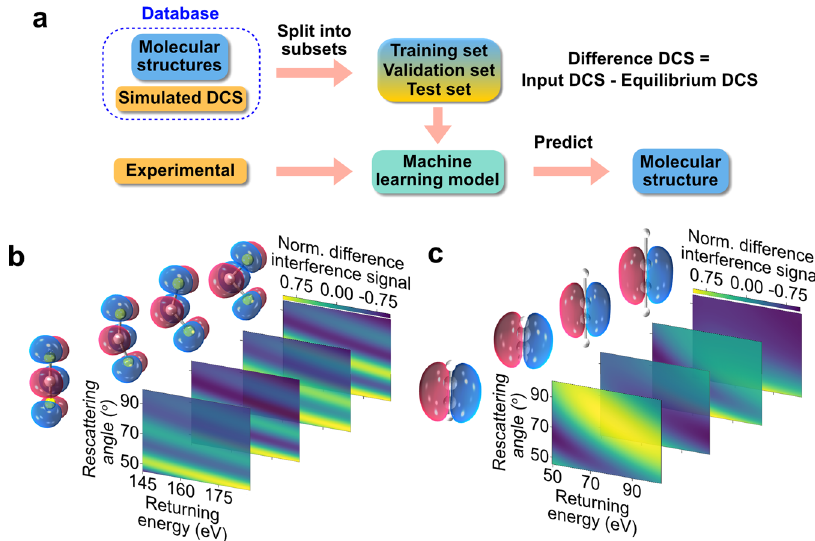
Fig. 1 Machine learning schematic. a A database of molecular structures and their corresponding simulated 2D-DCSs are split into three sets: training, validation, and test sets. Here, the simulated 2D-DCS maps are calculated via the independent atomic model (IAM). Once the machine learning (ML) model is validated, the experimental 2D-DCS map is used as an input to predict the molecular structure that most likely contributes to the measured interference signal. b , c Exemplary simulated difference 2D-DCS maps for four structures of carbon disul fi de ( b ) and acetylene ( c ) calculated from subtracting the corresponding 2D-DCS of the equilibrium molecular structure 33,34 . Fringe patterns are visible, enhancing the difference in the elastic scattering signal for the different molecular structures. The molecular coordinates (used as labels in ML algorithm) for C 2 H 2 ( a ) and CS 2 ( b ) molecules in Cartesian and polar coordinates, respectively. Table 1 Machine learning C 2 H 2 and CS 2 predicted